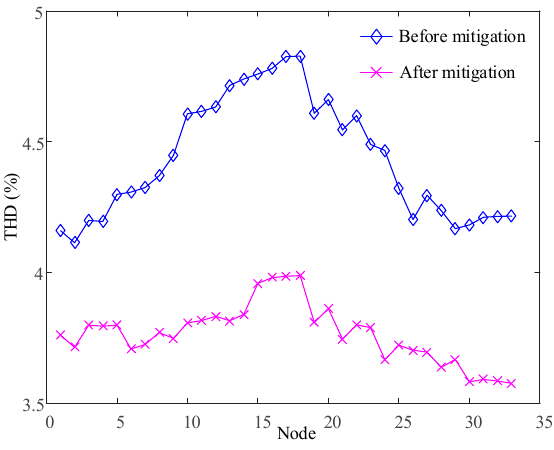
Figure 8. THD of each node at 13:00.